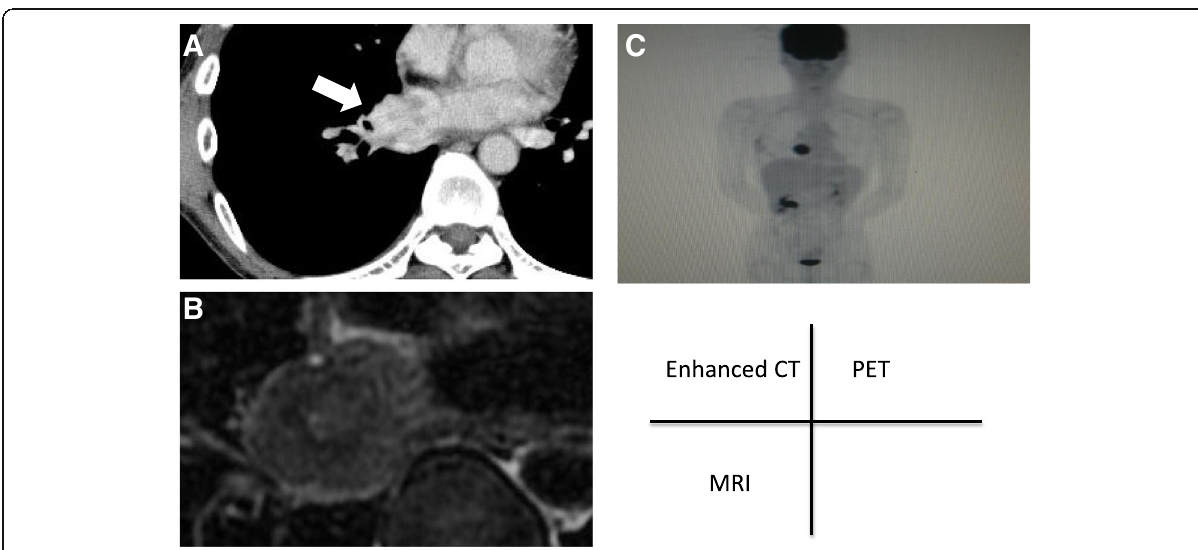
Fig. 1 Enhanced chest CT ( a ), MRI ( b ), and PET/CT ( c ). a A heterogeneous enhancement was demonstrated within the mass (arrow). b Ring-like low signal was shown within the mass. c High uptake of fluorodeoxyglucose was demonstrated within the